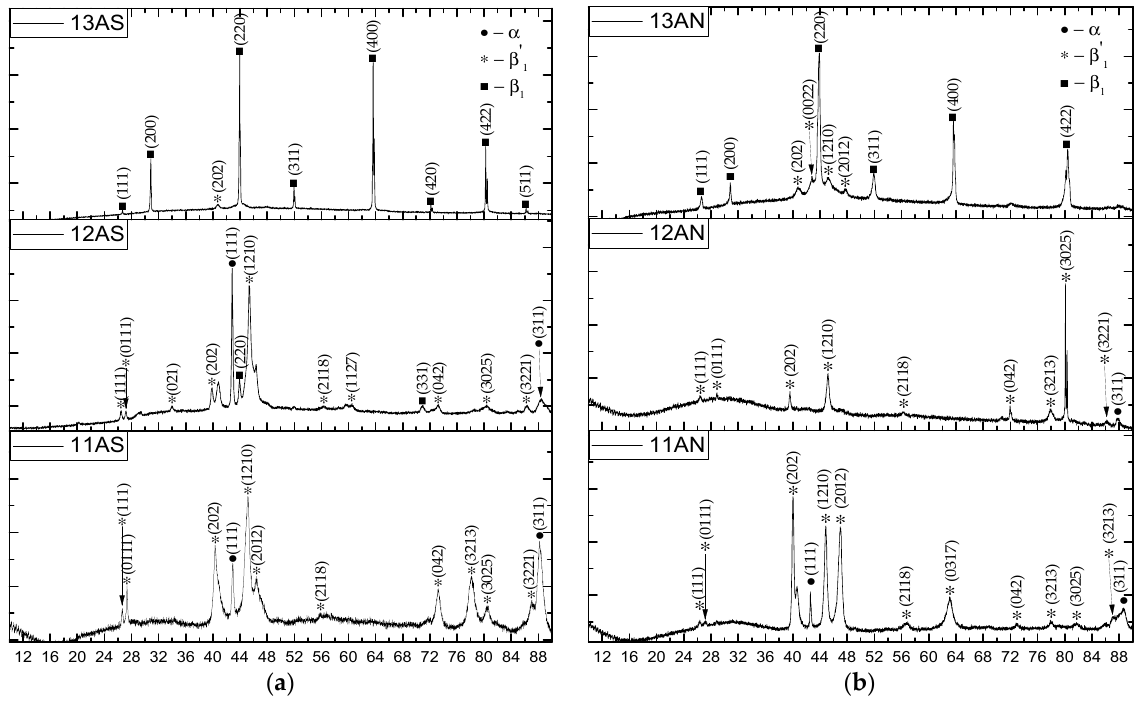
Figure 9. XRD diagrams of samples fabricated from Alloy 1: after printing ( a ); after annealing ( b ). As can be seen from Figure 10, the phase composition of the printed Cu–11Al–4Mn layers strongly depended on the printing regime. Thus, the Cu–11Al–4Mn alloy samples were characterized by a structure with the presence of the following two phases: R18-type martensite and α -phase. The appearance of the α -phase was caused by the eu- tectoid decomposition, which is typical for bronzes [33,34]. As can be seen from the comparison of SEM images (Figure 4) and XRD diagrams (Figure 10), in the low-heat-input regime, the cooling of the sample was faster and, consequently, less α -phase had time to separate. Accordingly, as evidenced by the high degree of intensity of X-ray peaks, mainly R18 martensite was present in the sample. Samples printed at high heat input values contained much more α -phase since high beam energies during print- ing contributed to high sample heating. From the XRD diagrams of the samples subjected to annealing (Figure 10b,d,f), it can be seen that the heat treatment allowed them com- pletely transform into the martensitic phase.